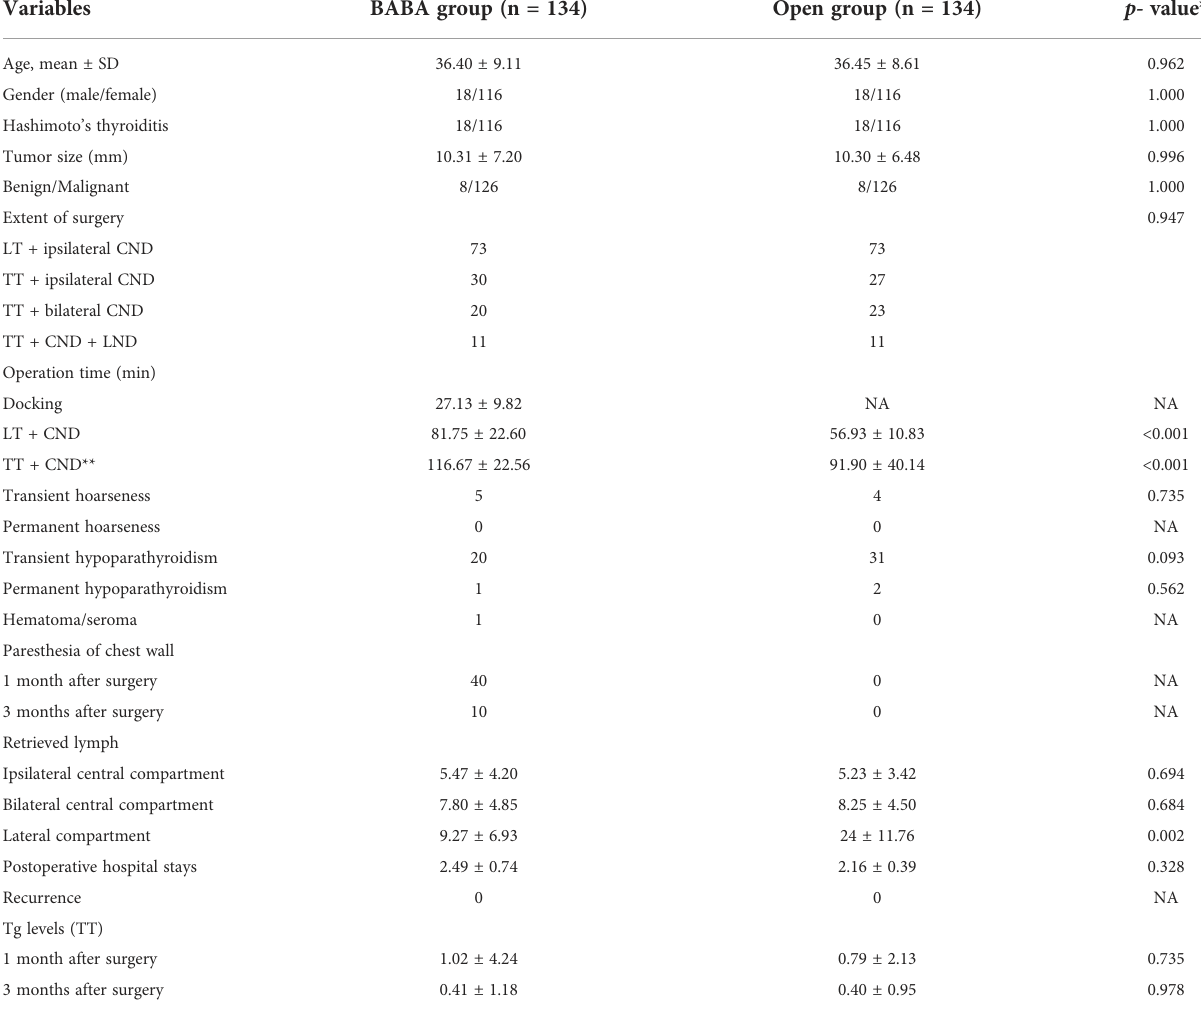
TABLE 1 Demographic data and surgical outcomes between robotic group (bilateral axillary breast approach) and conventional open